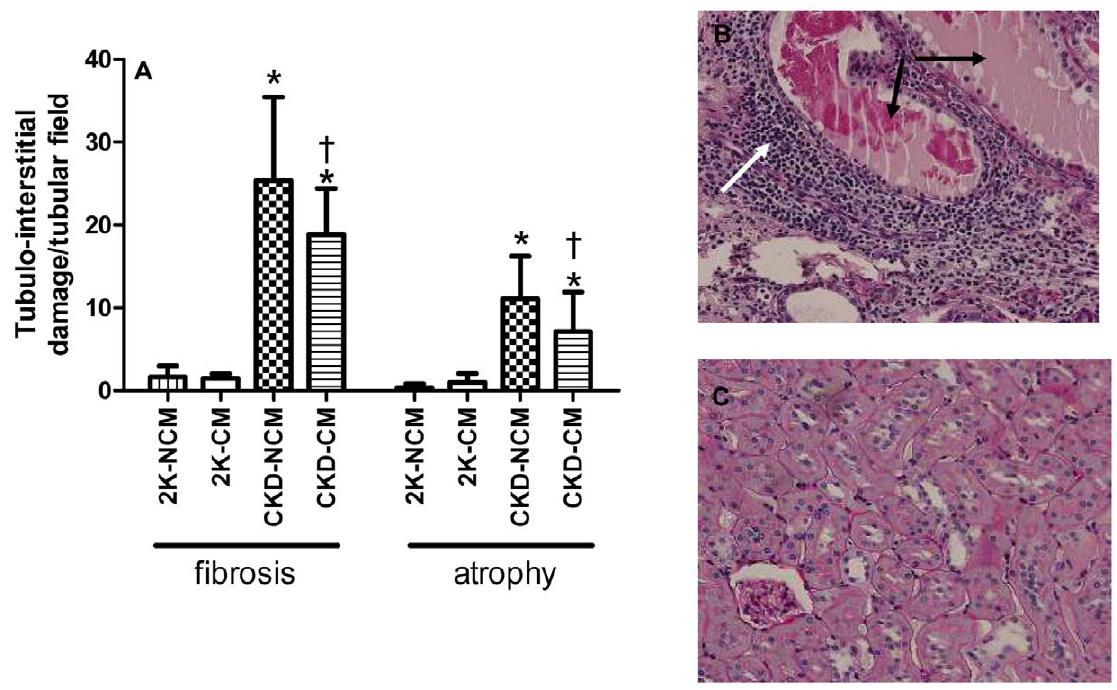
Figure 6. Tubulo-interstitial damage on PAS-stained sections was reduced after CM treatment in CKD rats. CM treatment decreased tubular fibrosis and atrophy (A). Differences between CKD (B) and healthy (C) tubular kidney tissue are shown. White arrow indicates infitration, black arrows showing proteincasts. 2K-NCM (n=6); 2K-CM (n=6); CKD-NCM (n=13); CKD-CM (n=13). *P , 0.05: CKD vs. 2K, { P , 0.05: CKD-CM vs. CKD-NCM.